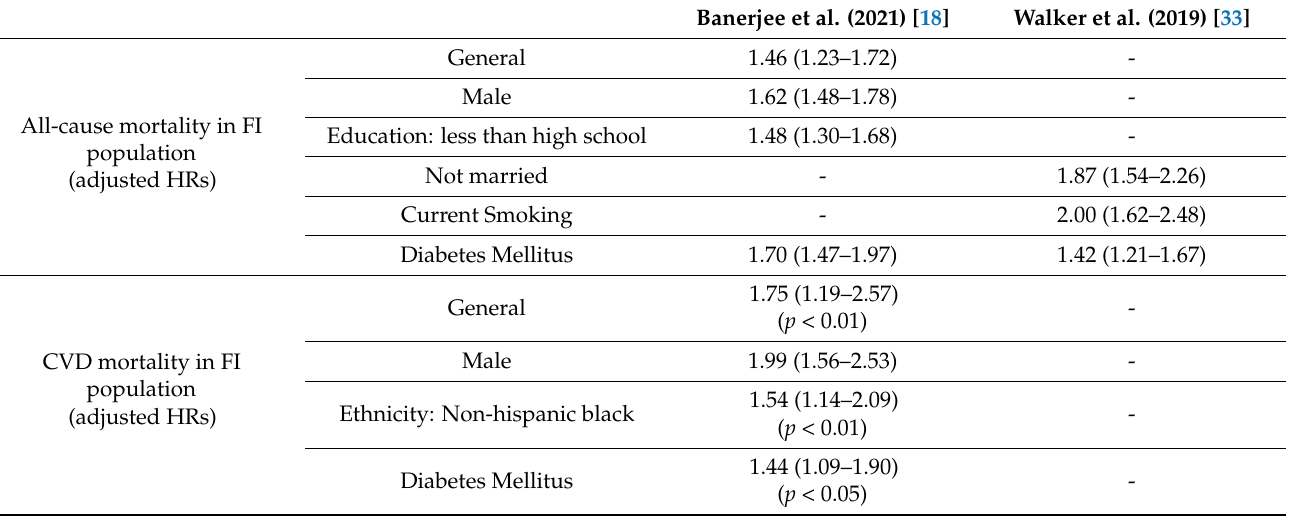
Table 4. Cardiovascular and all-cause mortality risk in food insecurity population, expressed as Hazard ratio (HR) and 95% CI. All data are p < 0.001, if not